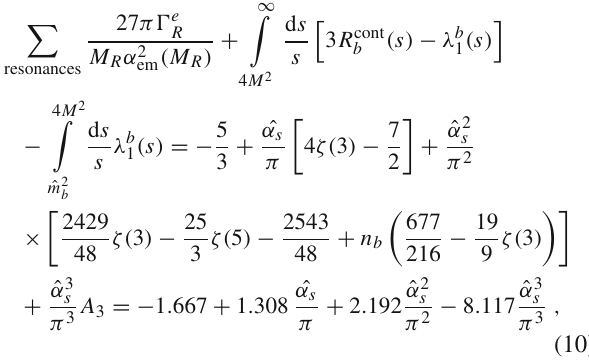
where ˆ α s = ˆ α s ( ˆ m b ) . The third-order coefficient A 3 is avail-